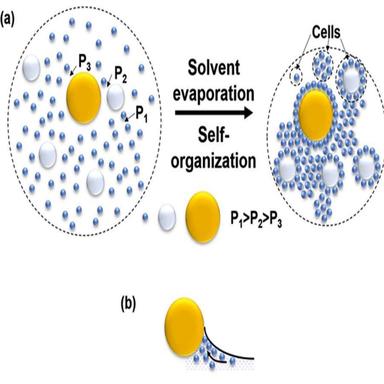
(a) Organization of particles on a droplet surface and (b) formation of "coffee ring" pattern during droplet drying. Reprinted (adapted) with permission from (AIChE Journal 2017; 63 (5); 1503–1511). Copyright © 2017, Wiley.